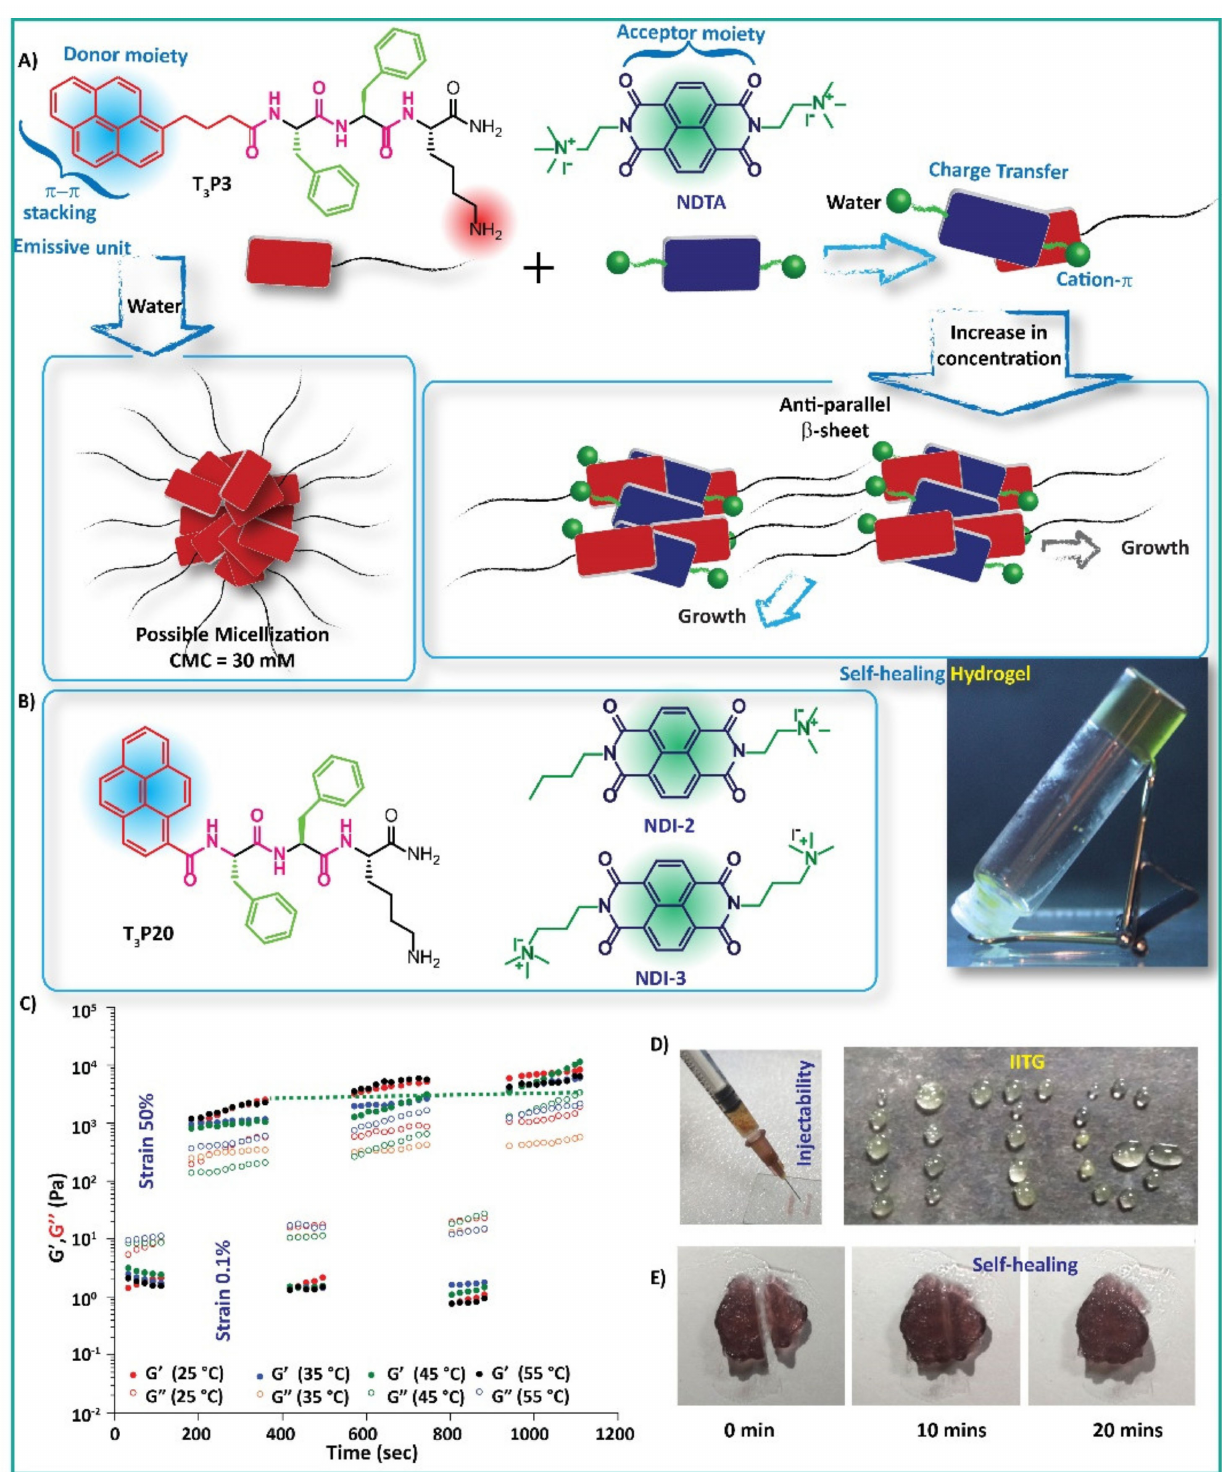
Figure 15. ( A , B ) Chemical structure of the pyrene-protected tripeptides (T 3 P3 and T 3 P20) and NDI derivatives (NDTA, NDI-2 and NDI-3).; schematic illustration of the self-assembly of T 3 P3 and co- assembly with NDTA; an inverted vial showing the co-assembled hydrogel. ( C ) Thixotropy test of the co-assembled hydrogel at different temperature. ( D ) Injectable behavior. ( E ) Macroscopic self-healing property of the co-assembled hydrogel; reproduced with permission from Ref. [5]. Copyright (2019) American Chemical